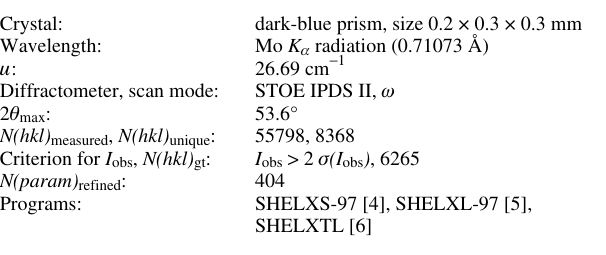
Table 1. Data collection and handling.